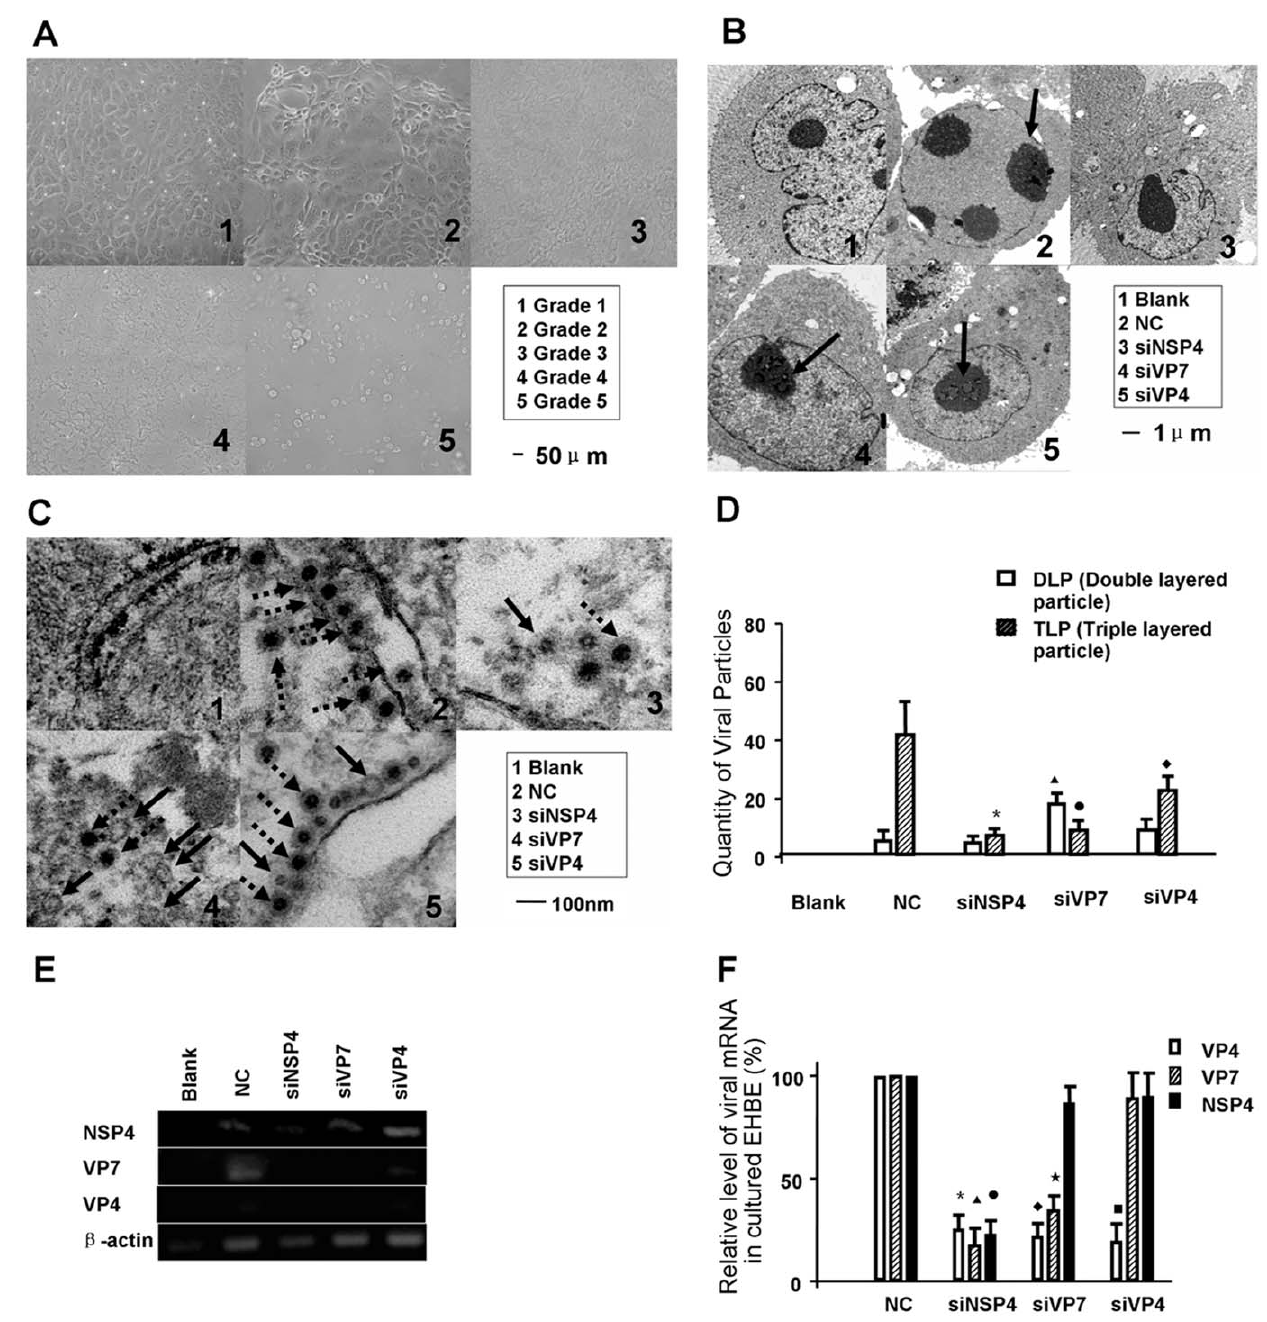
Figure 1. Rotavirus replication, maturity and cytopathic effect of cultured extrahepatic biliary epithelia (EHBE). (A) Cytopathic effect (CPE) grading of cultured EHBE. The severity of EHBE injury was graded from 0 to 4 with 4 being the most severe. (B) Ultrastructural CPE. siNSP4 transfected EHBE had normal structure. The other 2 siRNAs also protected the shape of EHBE, but nuclear degeneration was noted (pointed by black arrows). (C) Rotavirus particles. Significantly less double-layered particles (DLPs, pointed by black arrows) and triple-layered particles (TLPs, pointed by black arrow heads with dash lines) existed in siNSP4 protected EHBE. siVP7 caused more synthesis of DLPs. (D) Viral particle quantification. TLPs in EHBE significantly reduced in all siRNA trasfected groups ( * N ¤ P , 0.05, compared to NC). DLPs in siVP7 group was increased significantly ( m P , 0.05, compared to NC). (E) Representative gel images of reverse transcription polymerase chain reaction (RT-PCR). RT-PCR revealed the presence of 3 viral messenger RNAs (mRNAs) in NC group, but siNSP4 transfection reduced the level of NSP4 mRNA and completely inhibited the transcription of VP7 and VP4 mRNA. siVP7 caused absence of VP4 and VP7 mRNA. siVP4 reduced mRNA transcription. (F) Quantitative analysis using Gel Pro Analyzer. siNSP4 decreased the relative level of all viral mRNAs ( * m N P , 0.05, compared to NC). siVP7 inhibited the transcription of VP7 and VP4 mRNAs ( ¤ w P , 0.05, compared to NC). siVP4 only inhibited the mRNA expression of VP4 ( & P , 0.05, compared to NC).